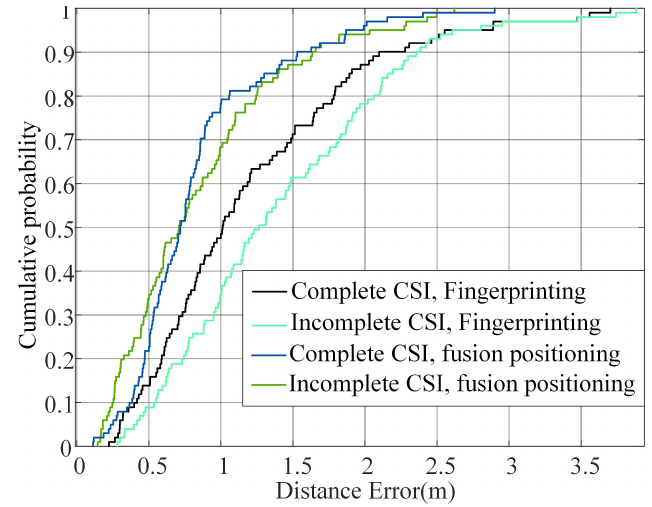
Figure 16. Cumulative error curves in both algorithms using complete or incomplete